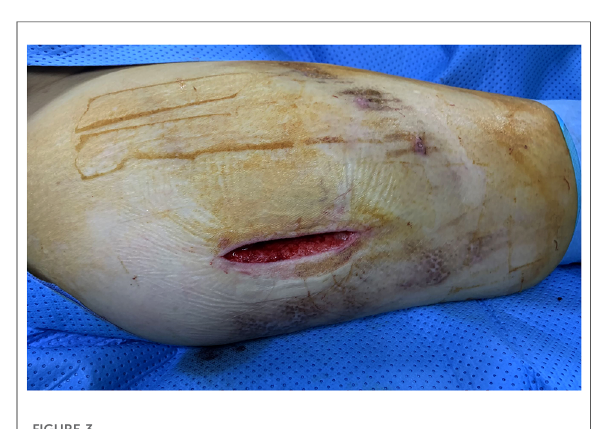
FIGURE 3 Operation data. No skin fl uctuations and no cavity were observed between the subcutaneous fat and the fascia iliaca of the anterolateral right